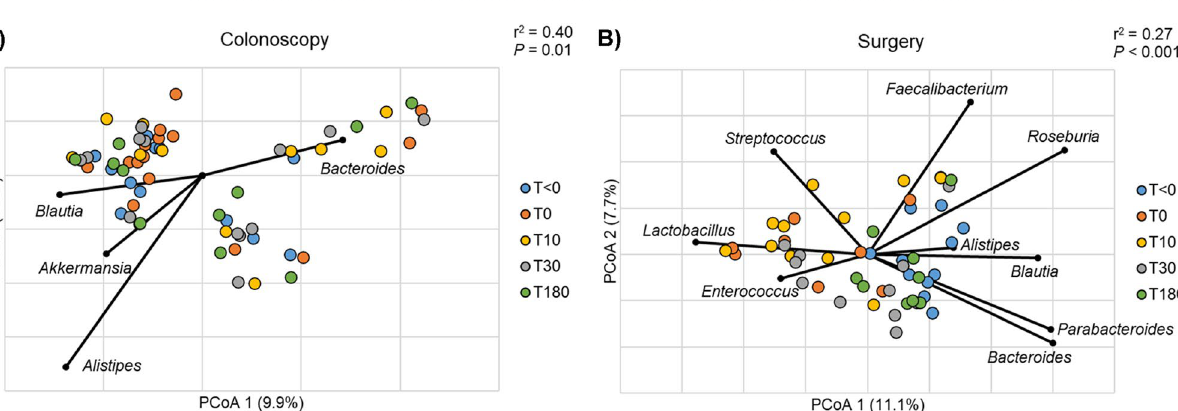
Figure 3. Principle coordinate analysis of Bray–Curtis distances among samples collected over study course in patients that underwent ( A ) colonoscopy and ( B ) surgery. Abundant genera significantly correlated to axis positions by Spearman correlation are shown (P < 0.05).